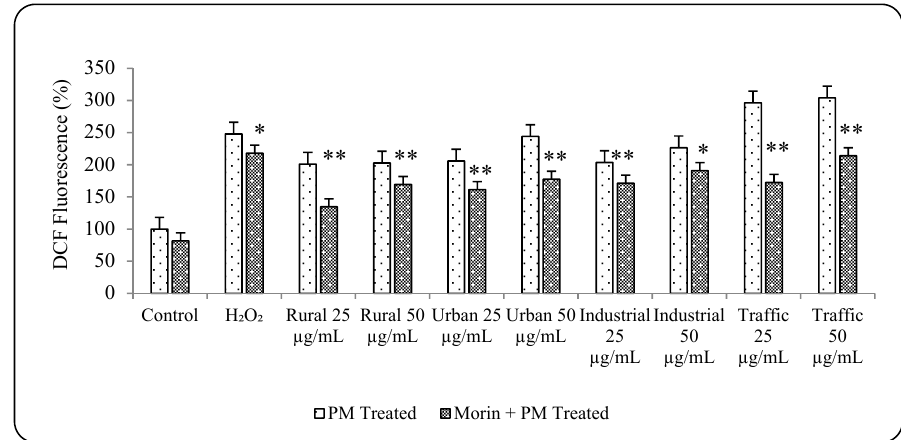
Figure 5. Effect of Morin on PM 2.5 induced ROS production. N = 3 ± SD, * p < 0.05 ** p < 0.01.